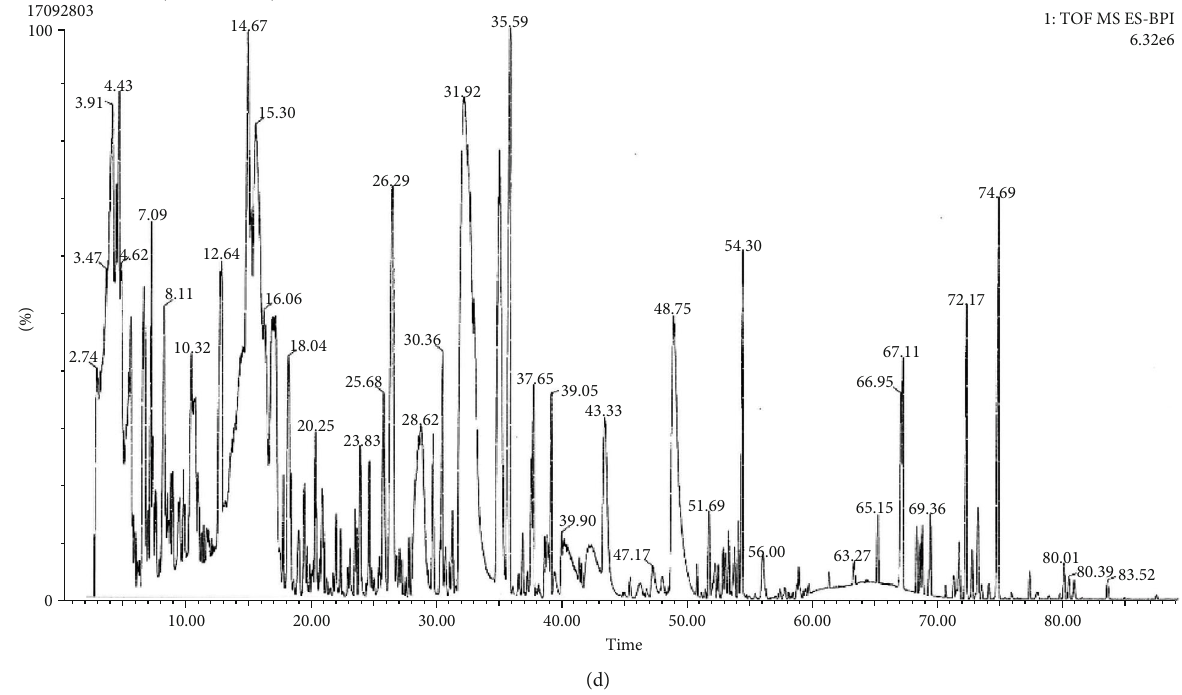
Figure 3: PG fragments in Z-100 and their e ff ect on IL-12p40 concentration. (a) IL-12p40 concentration in the culture supernatant of BMDM after stimulation for 24 hours with Z-100 (100 μ g/mL), nonanion fraction, or anion fraction. Symbols indicate a signi fi cant di ff erence compared with the saline group; ∗∗∗ P < 0 : 001 (Steel ’ s multiple comparisons test). Data show the mean ± S : E : ; n = 16 per group, pooled from 4 experiments. (b) General PG structure of Mycobacterium tuberculosis and digestion site of mutanolysin. Mutanolysin cleaves the bond between MurNAc and GlcNAc. (c, d) LC-MS/MS analysis of the anion fraction (c) and Z-100 (d). The anion fraction was measured at 100-fold concentration, and Z-100 was measured at 20-fold